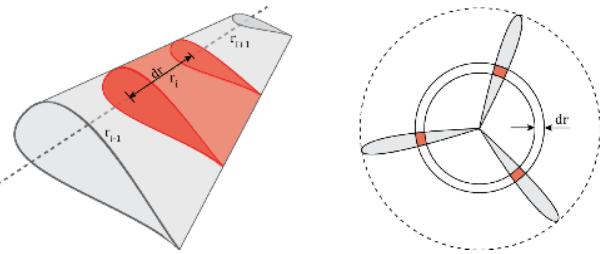
Figure 7. Blade elements of a three-bladed turbine [53].